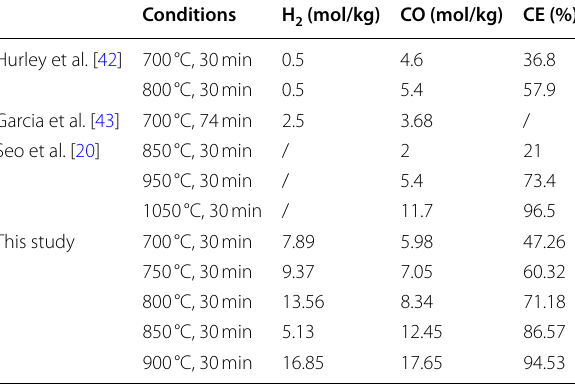
Table 2 Comparison with other studies of carbon